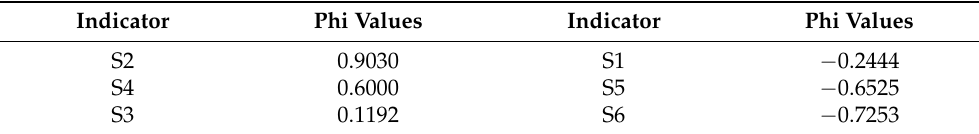
Table 12. PROMETHEE II results for emergency and safety management in healthcare facilities.